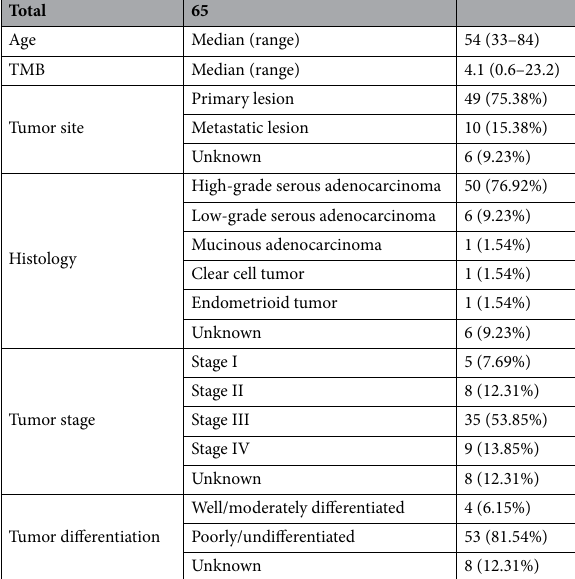
Table 1. Clinicopathologic features of 65 ovarian cancer